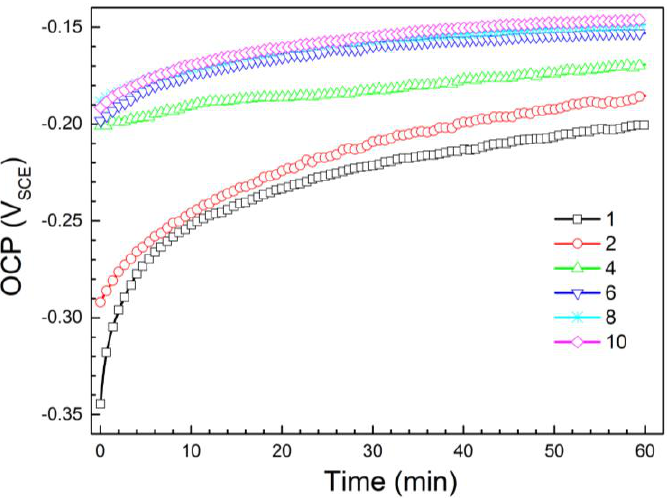
Figure 1. Open circuit potential curves of specimens immersed in the synthetic tap water solutions with different concentration ratios from 1 to 10 times for 60 min.